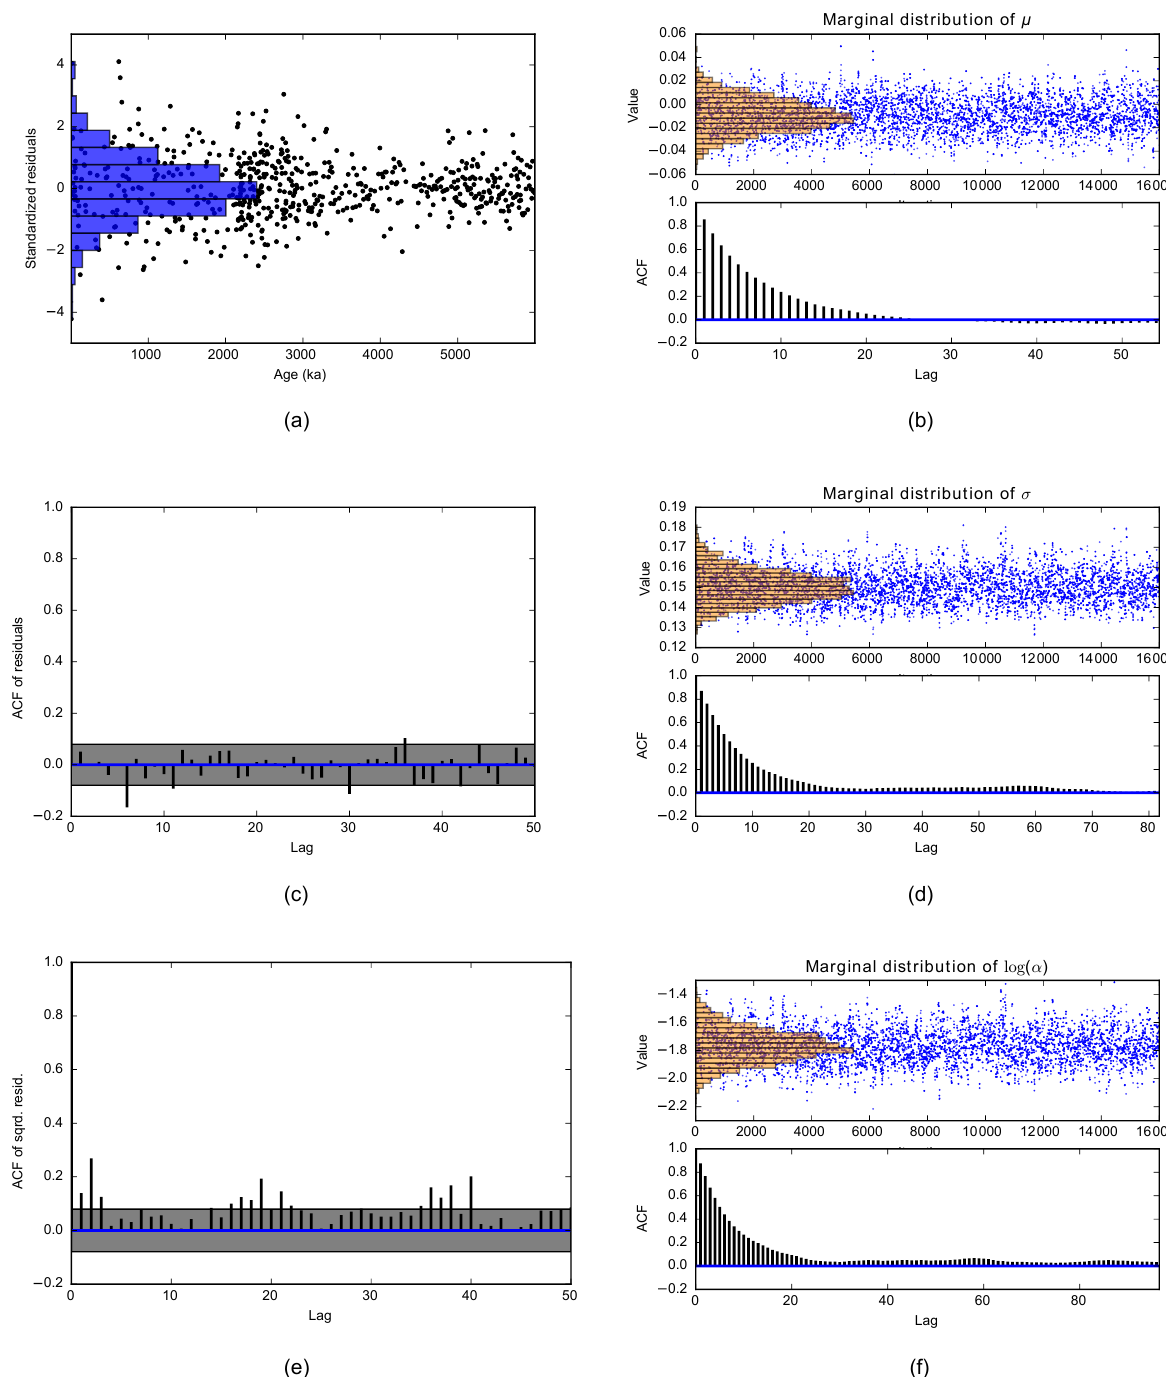
Figure 7. CARMA(1,0) background noise analysis. Panels (a) , (c) and (e) assess the fit. (a) Standardised residuals. (c) ACF of the residuals. (e) ACF of the squared residuals. The lag refers to an arbitrary scale on which the data are regularly spaced with a unit step. The grey portion is the 95% confidence region. Panels (b) , (d) and (f) show the samples of the MCMC and the posterior marginal distributions (top panel), jointly with the ACF of the MCMC samples (bottom panel). (b) Mean. (d) Standard deviation of the white noise term. Panel (f) shows log (α) , where α is defined in Sect.